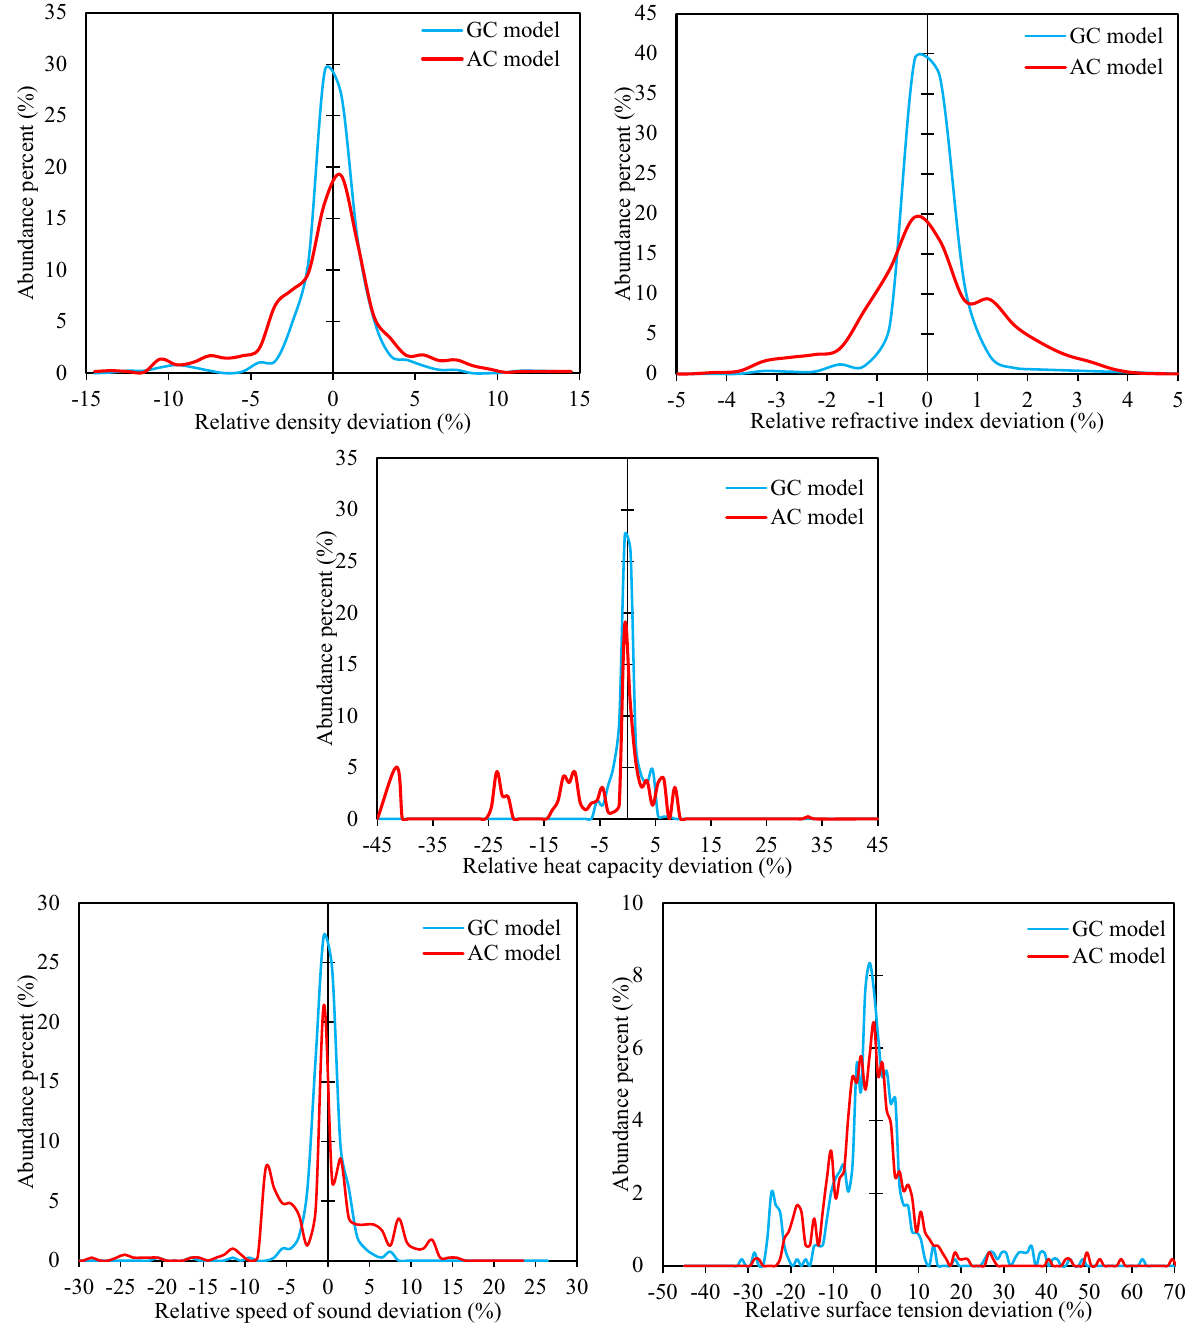
Figure 3. The comparisons for calculated relative deviation percentages of investigated physical properties for proposed GC and AC models for the entire